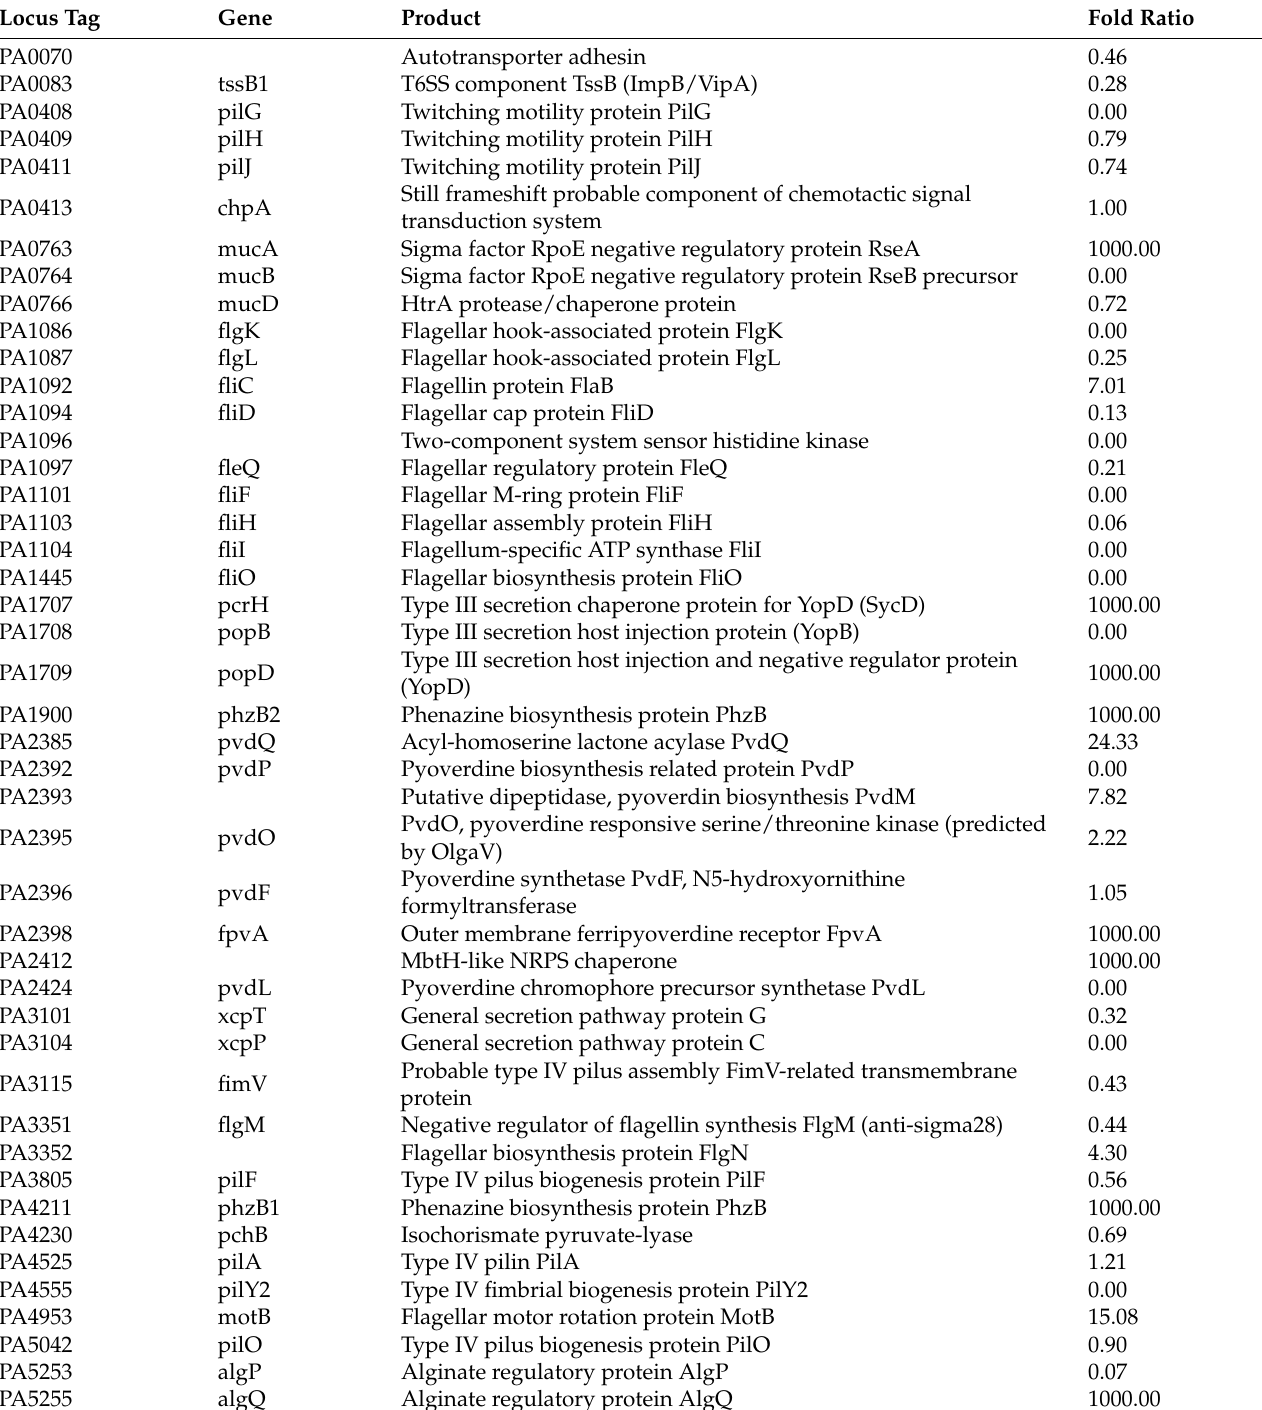
Table 2. Identified proteins associated with virulence of planktonic cells grown with control and antibiotic-impregnated